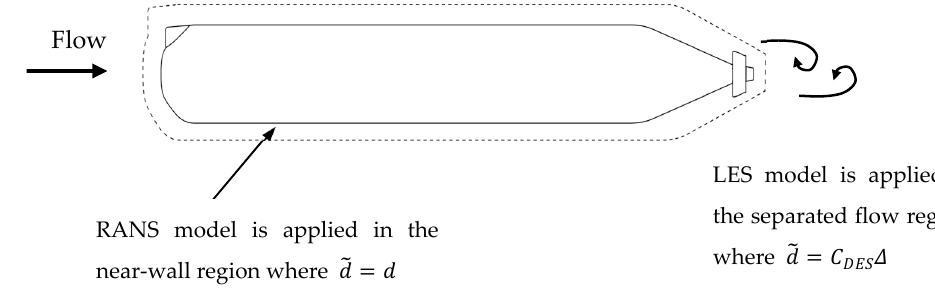
Figure 4. Hybrid RANS/LES approach applied to external flow simulation.